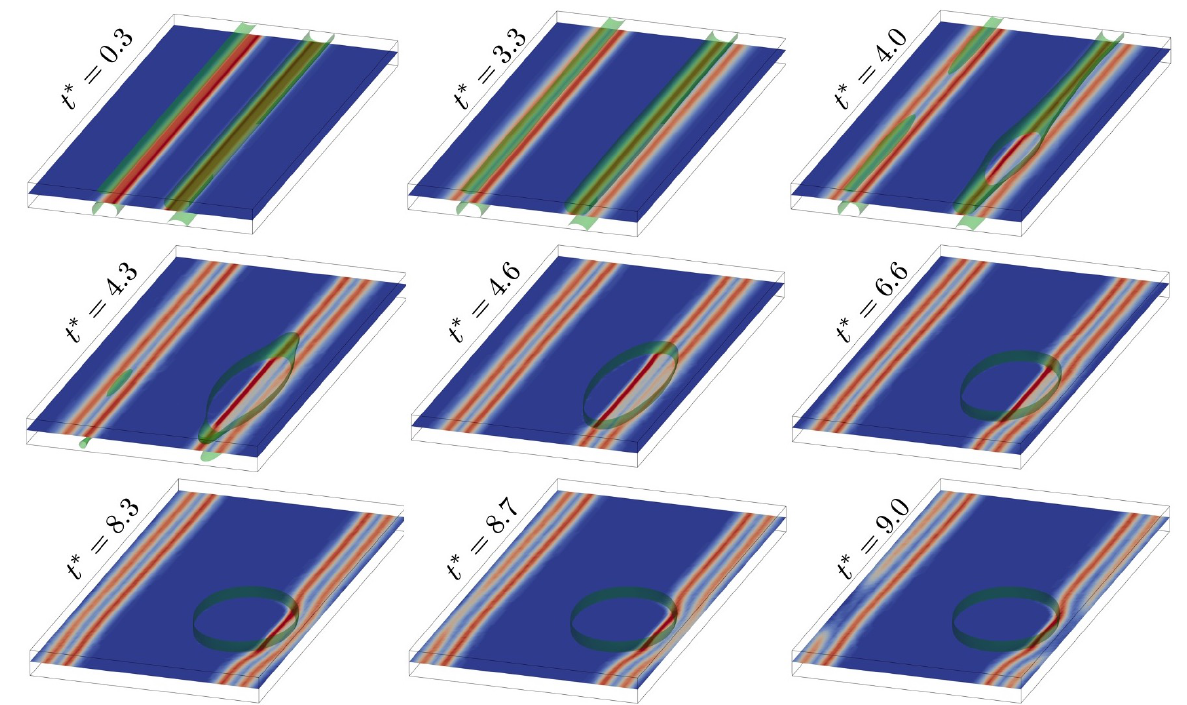
Figure 6. Solute segregation to, and spinodal decomposition at, an fcc edge dislocation gliding under an external shear deformation ¯ F xy = 0.10 in a system/simulation cell with orientation (32). 40% solute concentration isosurface shown in green. Dislocation line visualization is based on the scalar field |∇ φ 1 | + |∇ φ 2 | , which varies between zero (blue) and maximal (red) in the dislocation core. Note that the external shear deformation is applied at a rate much faster than t − 1 c . In addition, t c = 10 − 2 t a , and t 0 = 10 2 t a . See text for